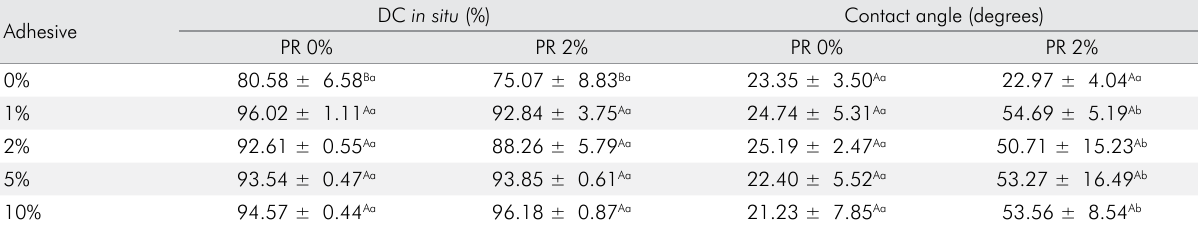
Table 1. Degree of conversion (DC, in percent, %) in situ and contact angle (in degrees). Adhesive